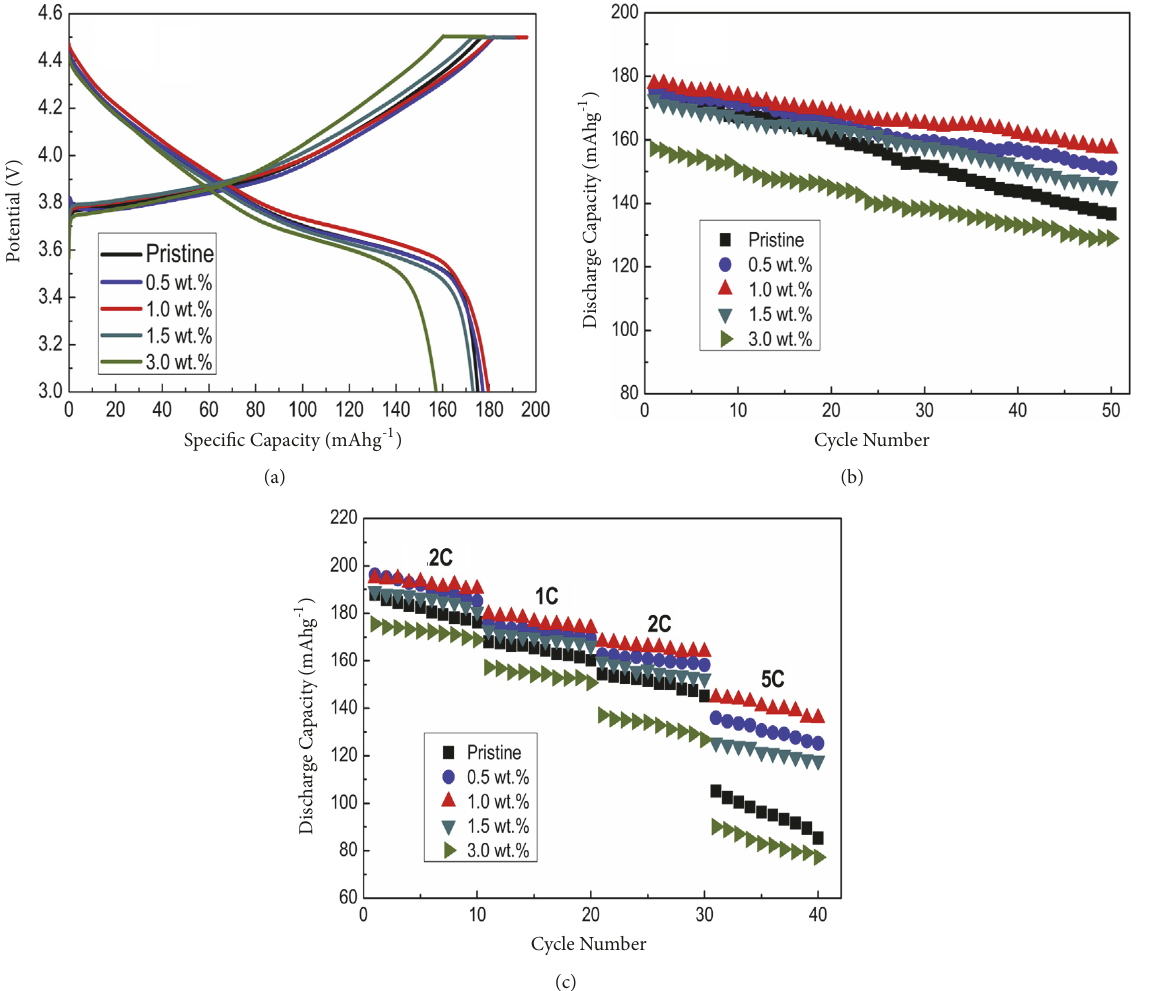
Figure 6: (a) Initial charge-discharge, (b) cycle performance, and (c) rate capability of TiO 2 coated NCM622 [33]. Copyright: Journal of Power Sources,